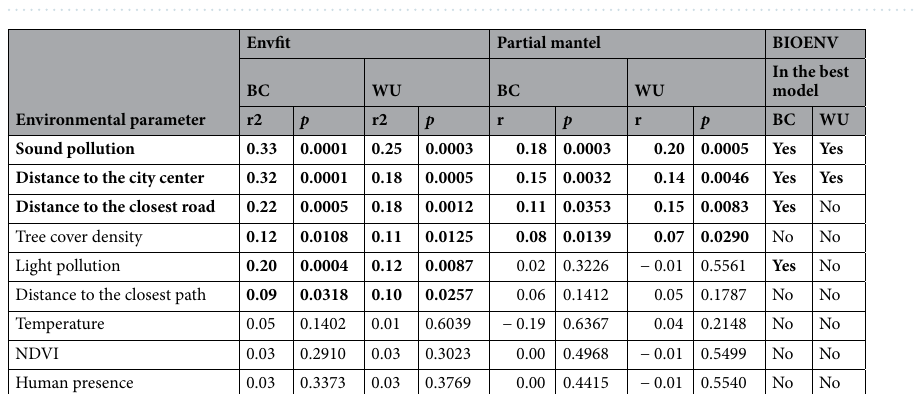
Figure 7. Scatter plots reporting the relationship between tree cover density and ( a ) Shannon’s diversity index and ( b ) the number of observed OTUs, ( c ) Faith’s phylogenetic diversity. The figure was generated in R version 4.0.0 68 .